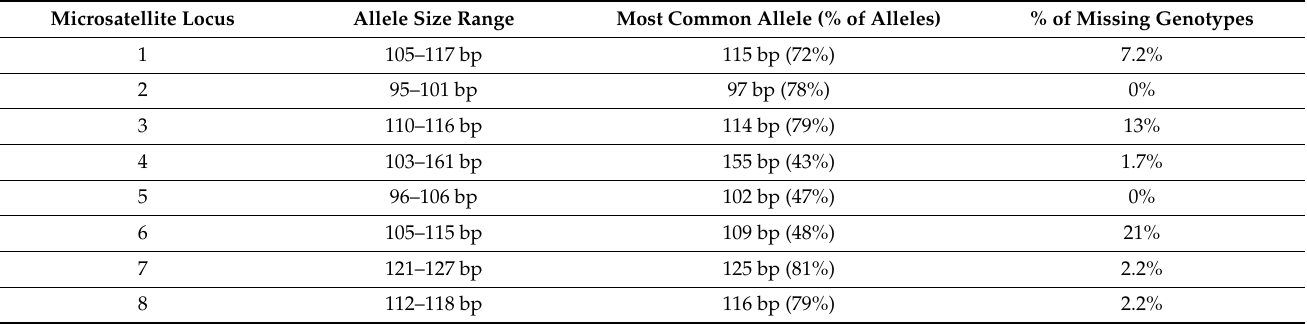
Table 4. Eight microsatellite loci demonstrate different degrees of polymorphism across samples tested.